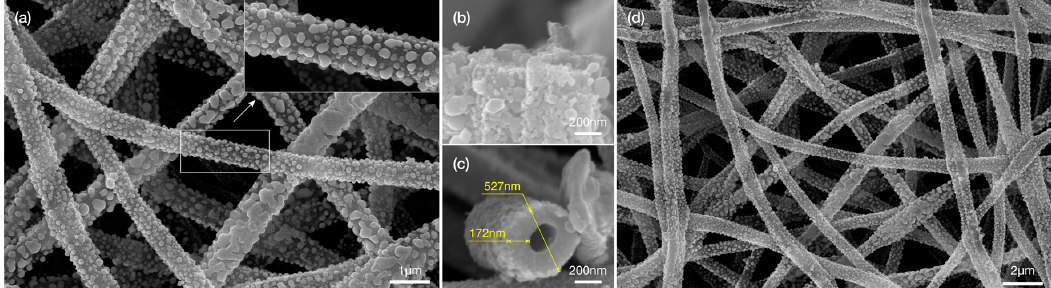
Figure 7. SEM images of palladium-coated PAA nanotubes ( a , d ) under different magnifications; ( b , c ) views of NTs under high magnification.